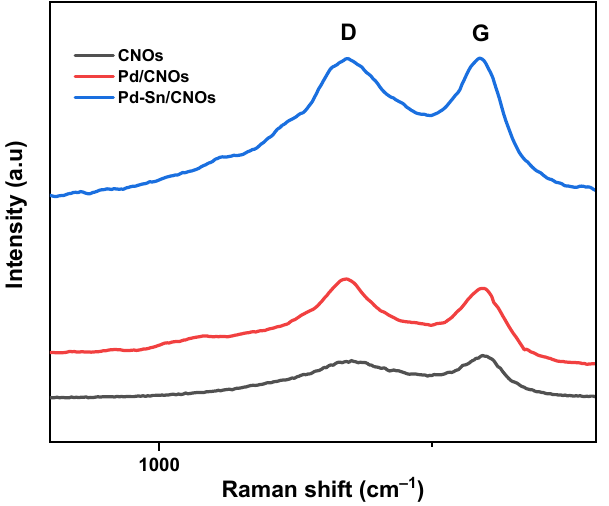
Figure 1. Raman spectra of CNO support material and Pd/CNO and Pd-Sn/CNO electro-catalysts.